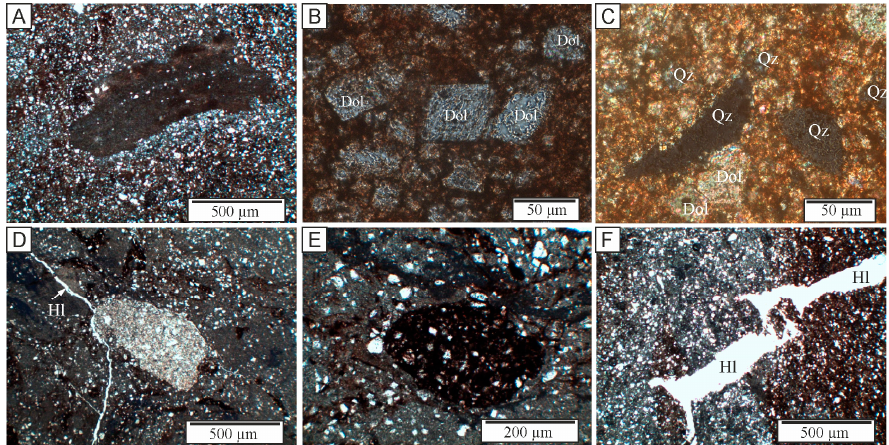
Figure 10. Thin section photographs of: ( A ) fine grained and semi-translucent, red-brownish, or greyish background with larger crystals of dolomite and rarely quartz (white spots). There is a fragment composed of only very fine grained semi-translucent dolomitic, dark mass in the centre of the image. ( B ) Euhedral, larger dolomite crystals (Dol—dolomite). ( C ) Anhedral, large quartz crystals (Qz—quartz). ( D ) The light colour, rounded dolomitic fragment and halite vein (Hl—halite). ( E ) The dark coloured rounded fragment. ( F ) Irregular halite veins (Hl—halite).